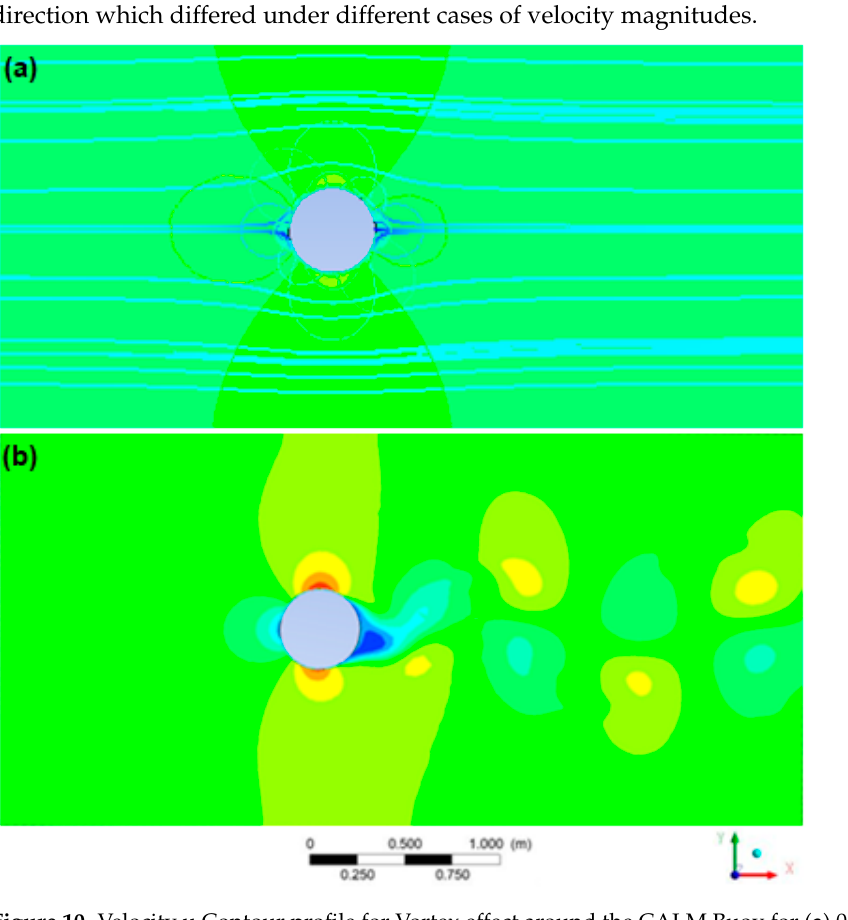
Figure 11. Vortex effect on the free-floating buoy showing flowlines and fluid-structure interaction